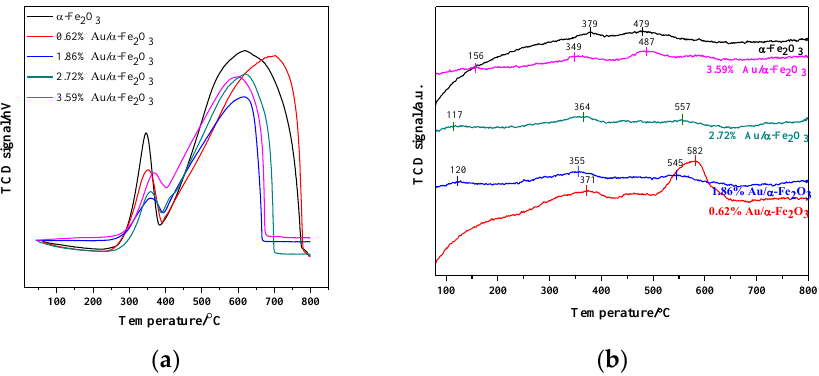
Figure 7. ( a ) H 2 temperature-programmed reduction (H 2 -TPR) profiles and ( b ) temperature programmed desorption of ammonia (NH 3 -TPD) profiles of α-Fe 2 O 3 and Au/α-Fe 2 O 3 catalyst calcined at 300